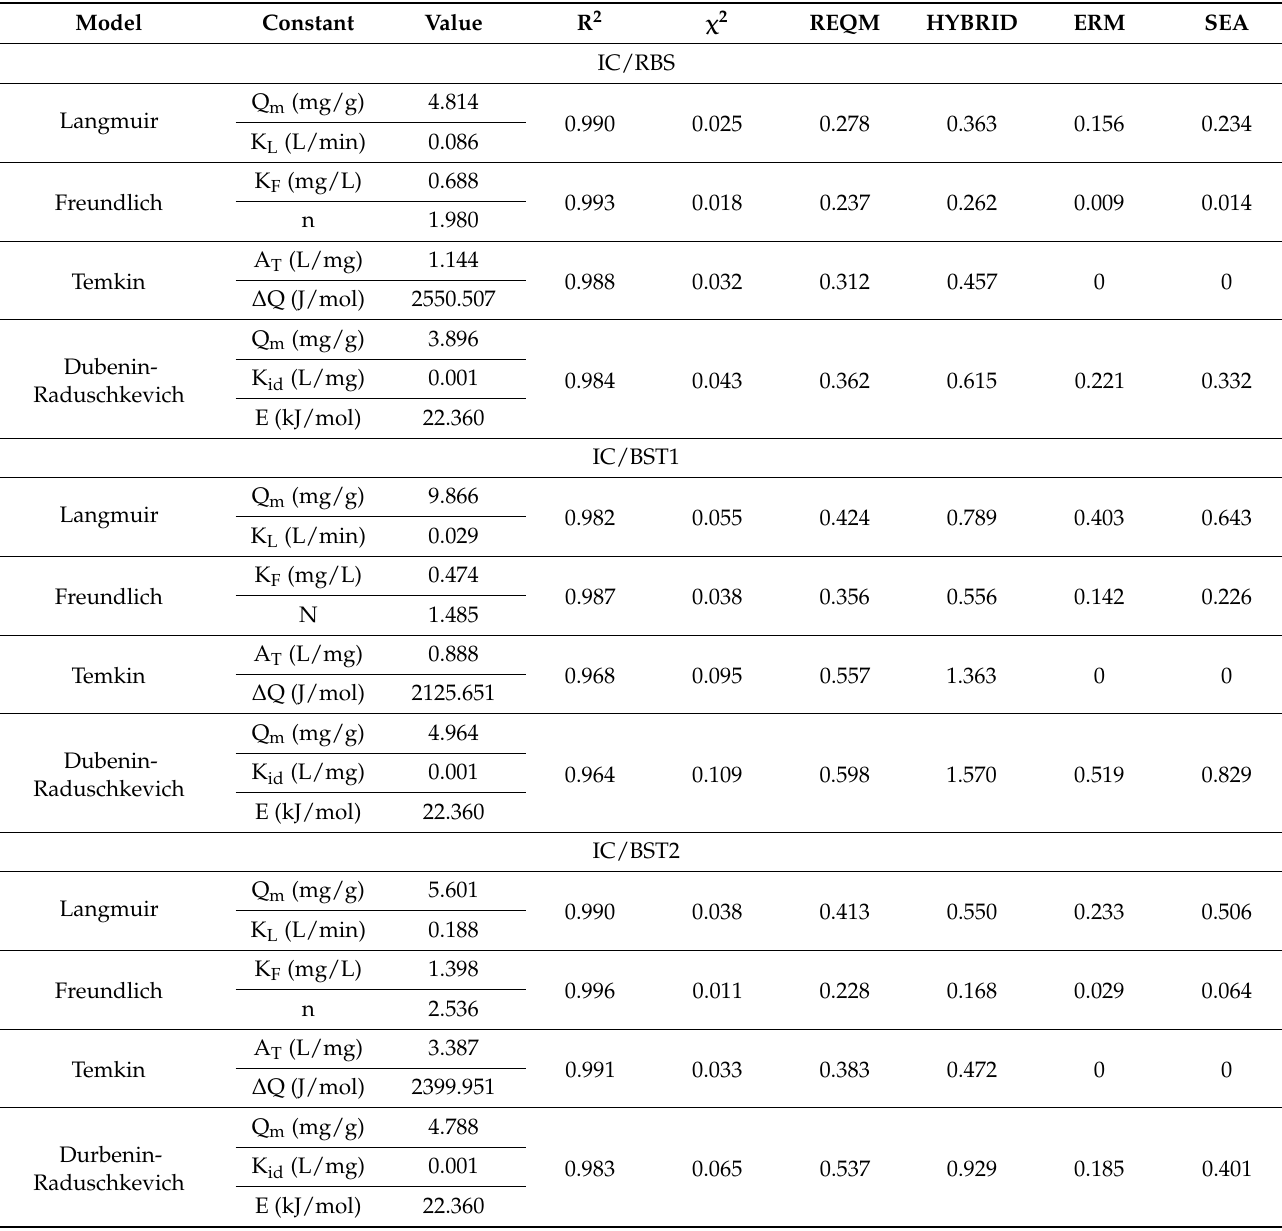
Table 7. Data from the Langmuir, Freundlich, and D–K–R isotherms for the sorption of IC by RBS, BST1, and BST2 samples.